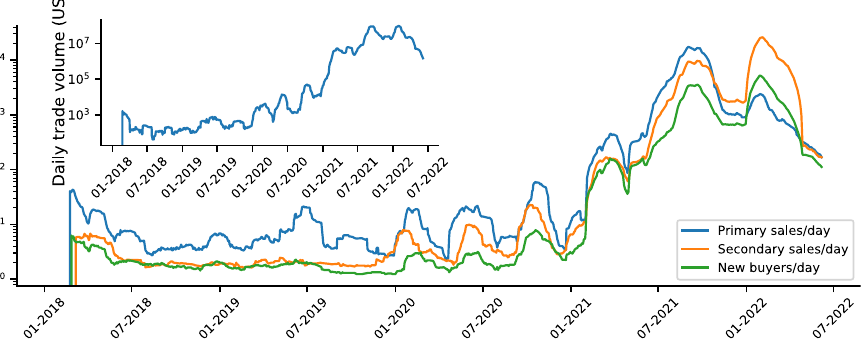
Figure 3. The collectible market boom. 30-day rolling average of the daily number of primary sales (blue line), secondary sales (orange line) and new buyers (i.e., new wallet addresses buying an NFT for the first time, green line). Inset: 30-day rolling average of the daily trade volume (in USD).